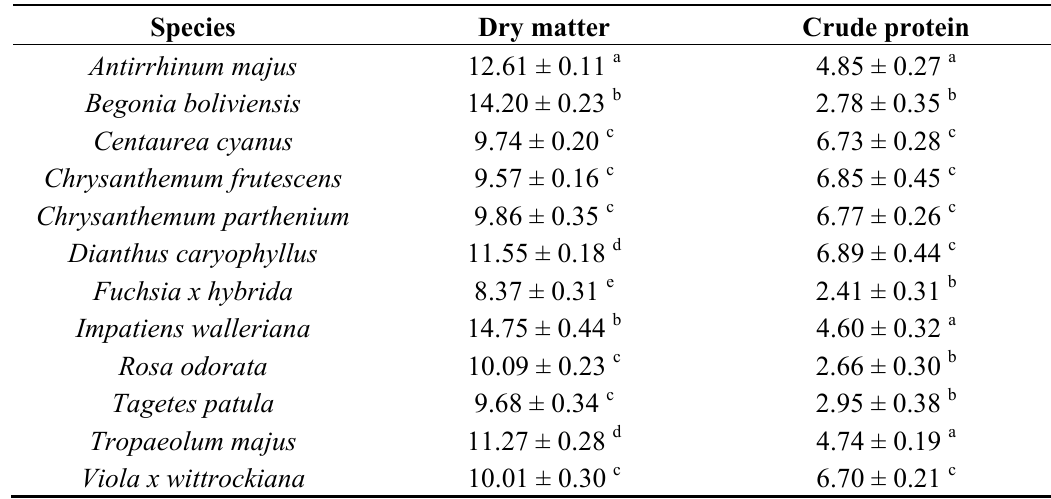
Different superscripts in each column indicate the significant differences in the mean at p < 0.05. Table 2. Dry matter (% w/w) and the content of crude protein (g/kg of FM) in 12 species of edible flowers, n = 10.